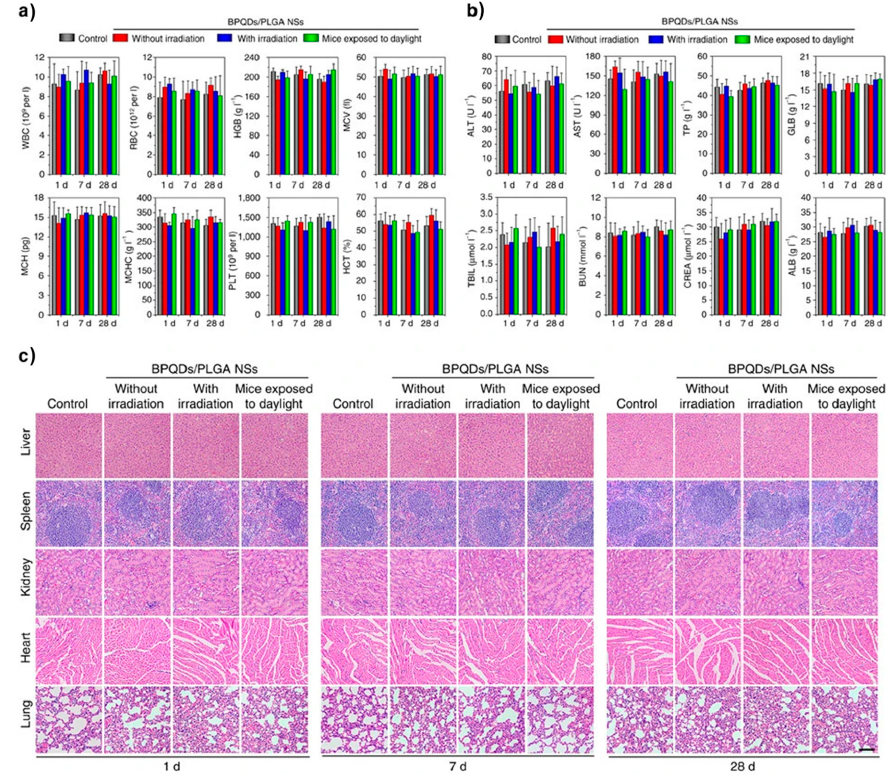
Figure 27. ( a ) Hematological data of the mice intravenously injected with the BPQDs/PLGA NSs at 1, 7, and 28 days post – injection. The terms are as follows: white blood cells, red blood cells, hemoglobin, mean corpuscular volume, mean corpuscular hemoglobin, mean corpuscular hemoglobin concentration, platelets, and hematocrit. ( b ) Blood biochemical analysis of the NSs – treated mice at